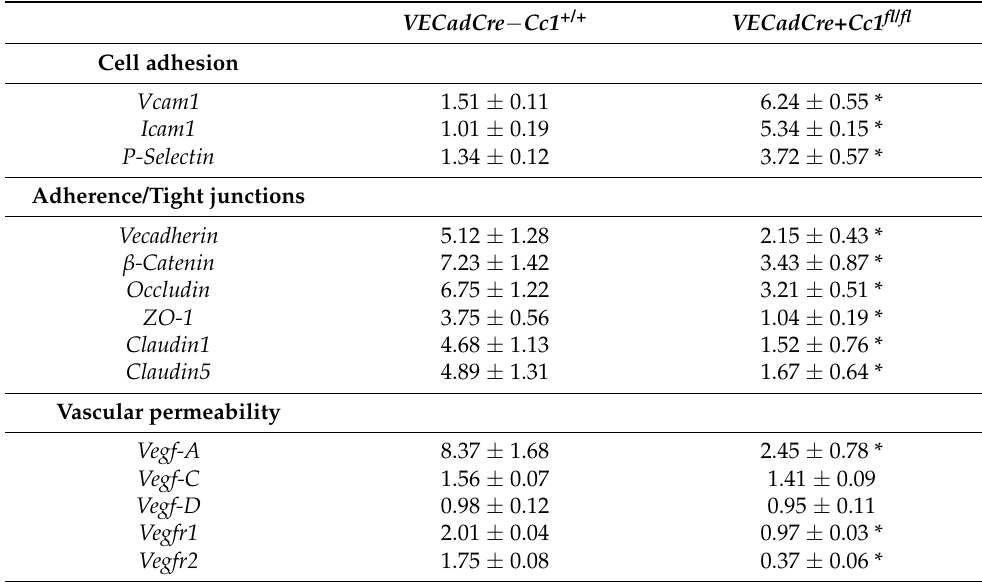
Table 1. mRNA levels of genes in primary liver endothelial